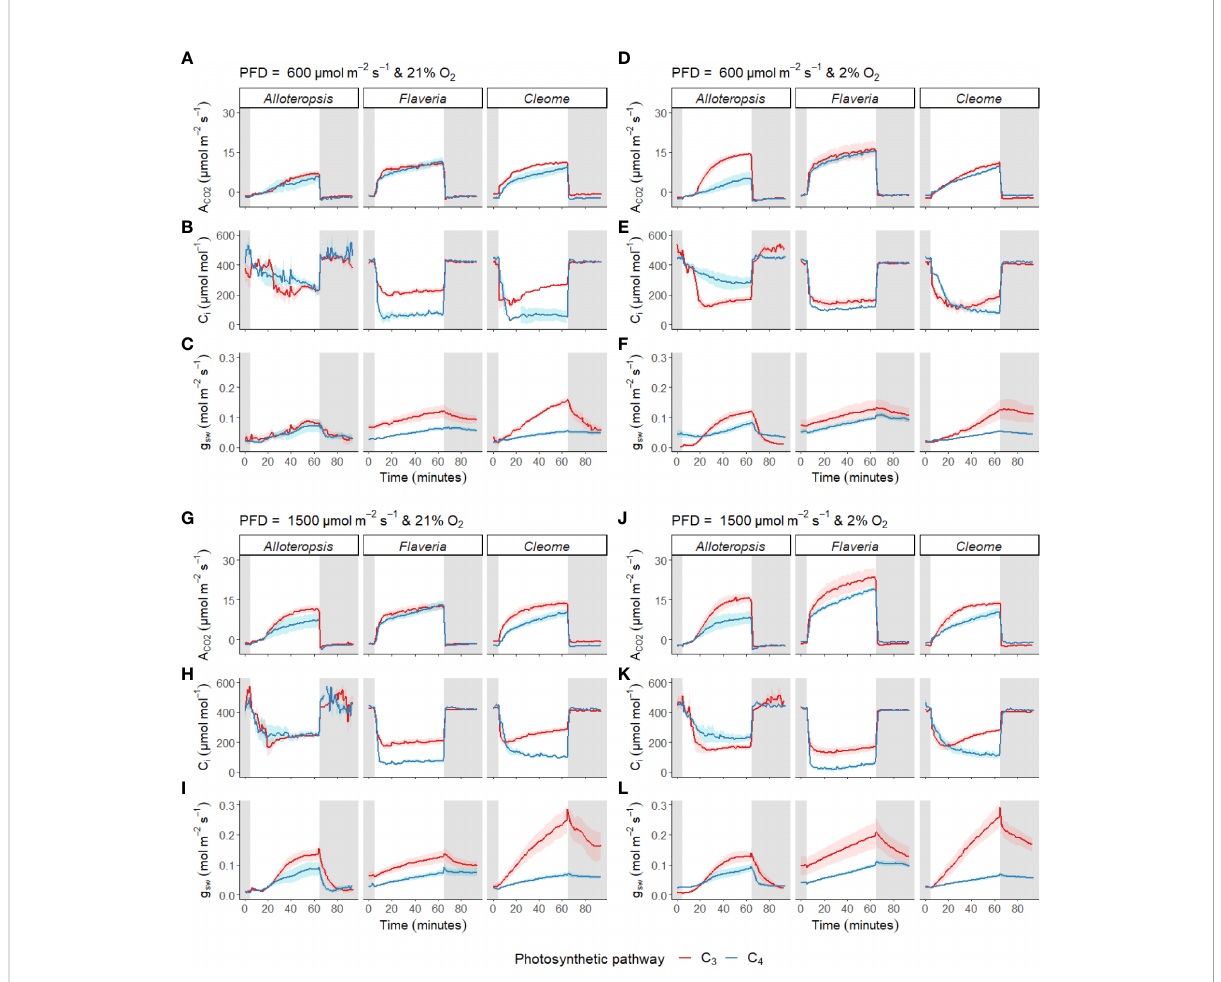
FIGURE 4 Measurements of gas exchange during light induction in phylogenetically linked C 3 and C 4 Alloteropsis , Flaveria and Cleome species. Leaves were acclimated to darkness, exposed to 1 hour of light, and returned to darkness for another half hour. Plots show net CO 2 assimilation (A CO2 , A, D, G, J ), intercellular CO 2 concentration (C i , B, E, H, K ) and stomatal conductance to water vapour (g sw , C, F, I, L ) across the light induction experiment, at PFD = 600 µmol m -2 s -1 and PFD = 1500 µmol m -2 s -1 , in 21% and 2% O 2 . Ribbons represent standard error of the mean (n =